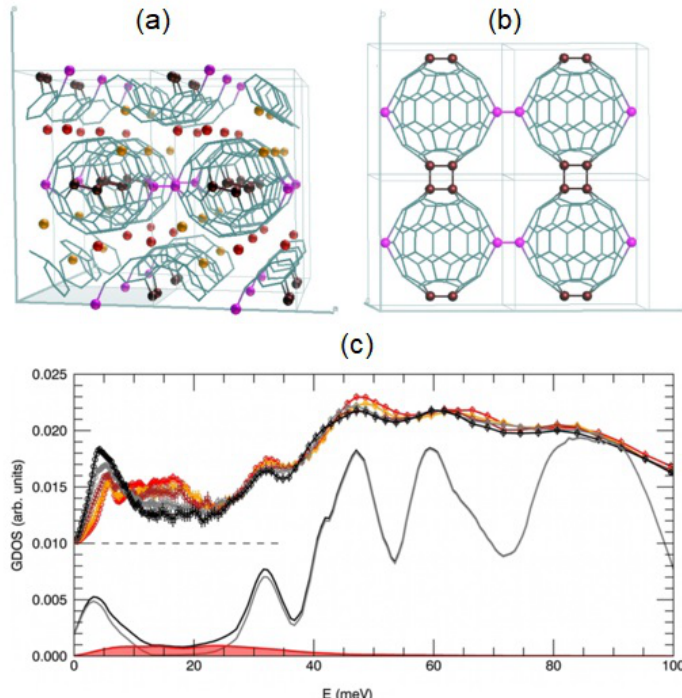
Figure 8. ( a ) Structure of Li 4 C 60 obtained from DFT (VASP) geometry optimization within space group I2/m . Gray sticks are carbon bonds; magenta and brown spheres are carbon atoms involved in covalent intermolecular bonds, including [2 + 2] bridges and single bonds. Red and yellow spheres represent two different types of intercalated ions, Li T and Li O , respectively. ( b ) View along the c -axis of one polymeric plane (the Li ions have been omitted for clarity). ( c ) ( Top ) Generalized Density of States (GDOS) derived from INS data collected between 300 K (polymer phase) and 700 K (monomer phase): red, 300 K; yellow, 610 K; brown, 630 K; gray, 640 K; and black, 700 K). ( Bottom ) GDOS extracted from the MD simulations at 800 K (see text) in the monomer phase (black solid lines, total GDOS; gray solid line, carbon GDOS; red area, lithium GDOS). The INS spectra were collected on Mibemol (LLB, Saclay, FR). Reproduced from Ref. [246] with permission from APS (https://doi.org/10.1103/PhysRevLett.113.215502) (accessed on 28 April